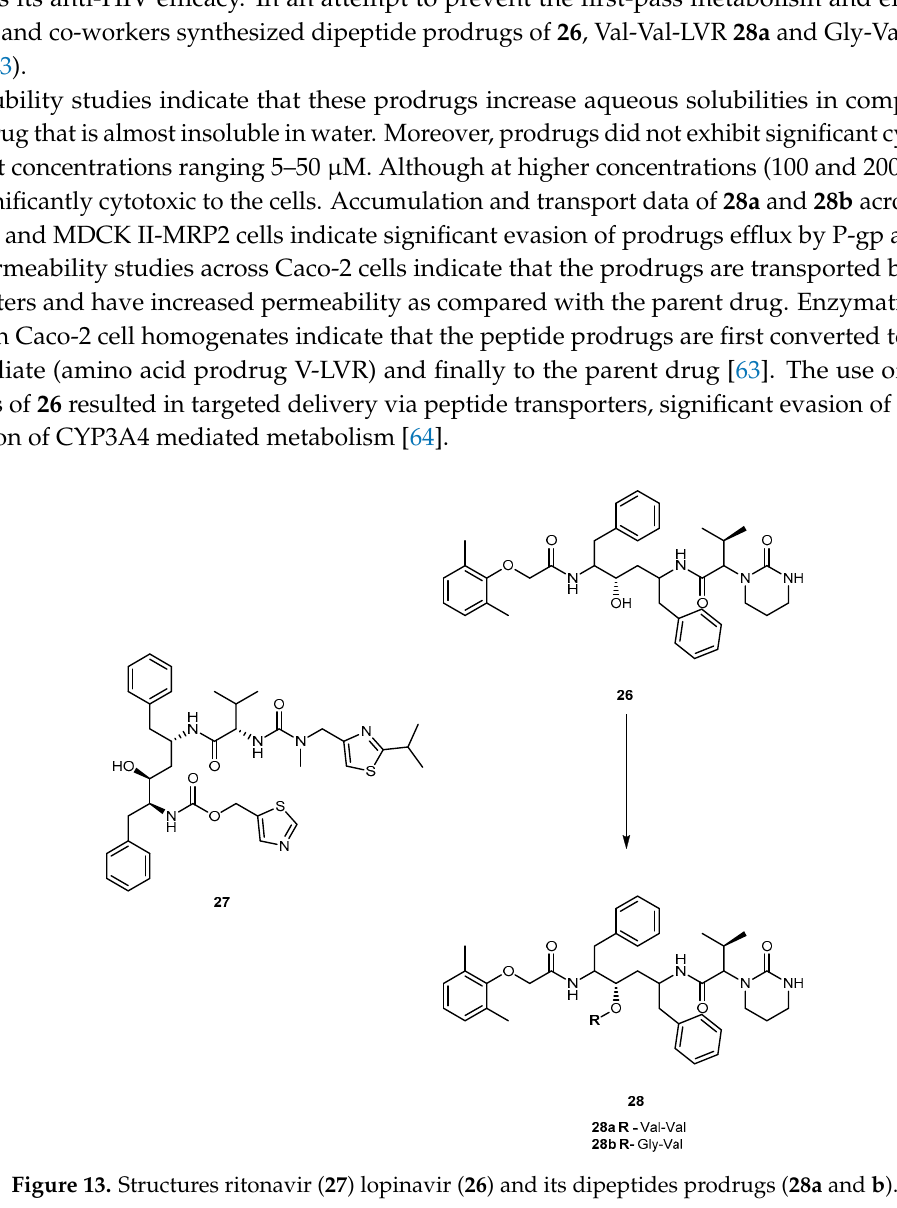
Figure 14. Chemical structures of drugs, lamivudine ( 29 ), adefovir ( 30 ), entecavir ( 31 ) and PMEA ( 32 ), used against chronic infection of hepatitis B virus.